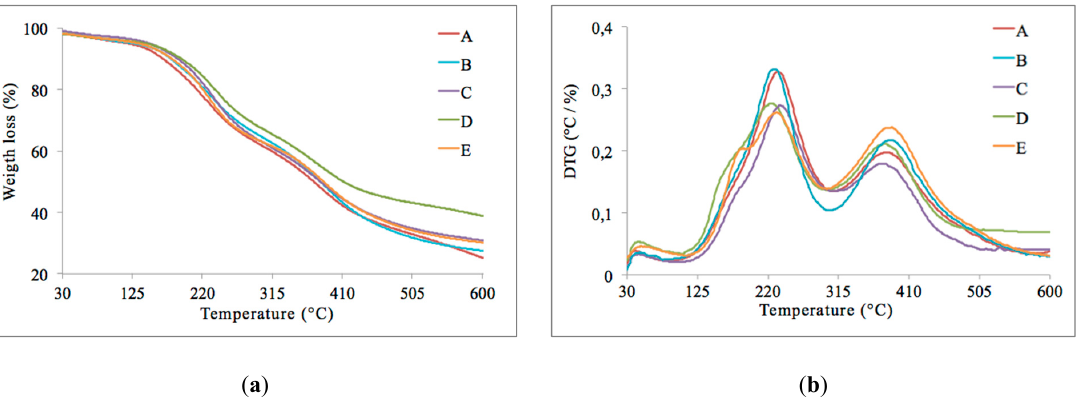
Figure 5. ( a ) Thermogravimetric (TG) curves and ( b ) derivative thermogravimetric (DTG) curves for the five samples of CNCs studied.